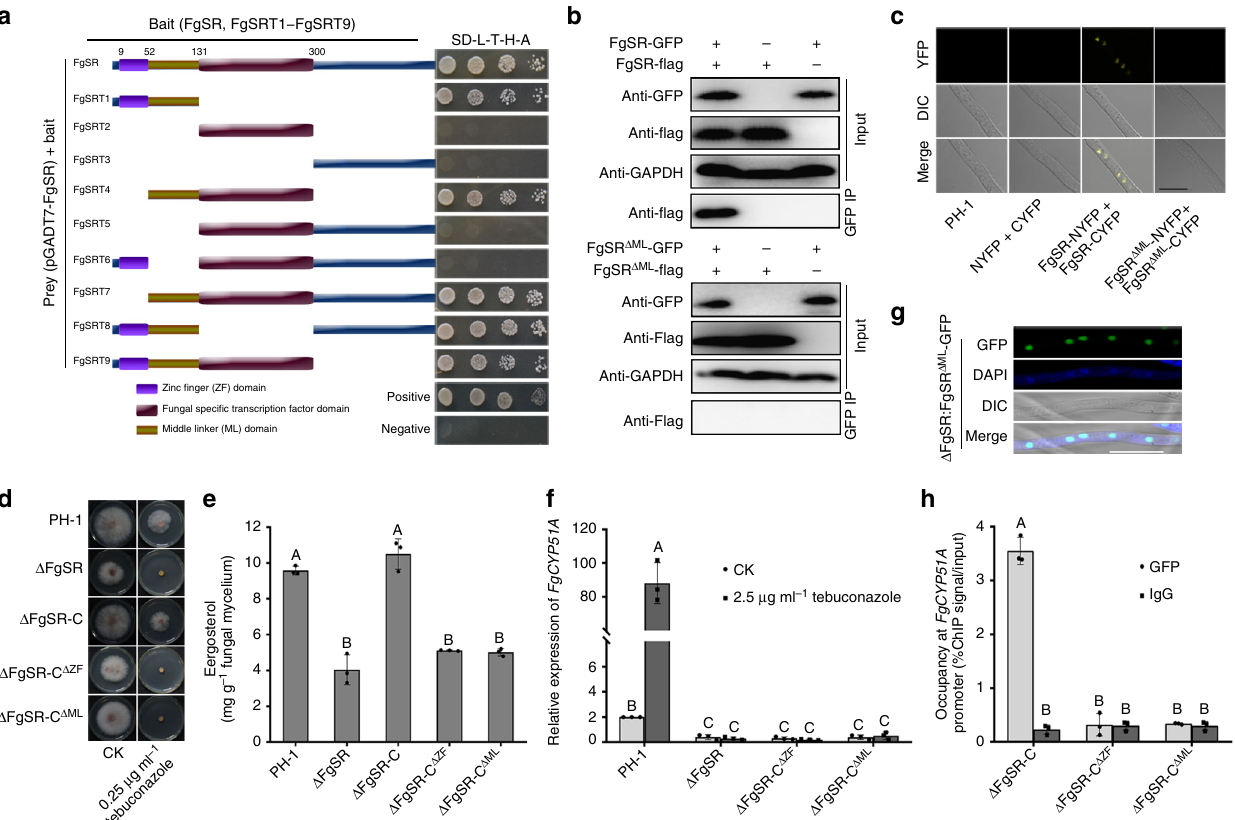
Fig. 5 The homodimerization of FgSR is required for its binding to the FgCYP51A promoter. a The yeast two-hybrid (Y2H) assay revealed that the middle linker (ML) domain of FgSR is required for its homodimerization. Serial dilutions of yeast cells (cells ml − 1 ) transferred with the prey (pGADT7-FgSR) and bait (a series of truncated FgSR (indicated in the left panel) constructs were assayed for growth on SD-Leu-Trp-His plates (right panel). b FgSR lacking of the ML domain did not interact with itself in the co-immunoprecipitation (Co-IP) assay. c FgSR lacking of the ML domain did not interact with itself in the bimolecular fl uorescence complementation (BiFC) assay. FgSR-NYFP/FgSR Δ ML -NYFP, and FgSR-CYFP/FgSR Δ ML -CYFP were co-transformed into the wild type. YFP signals were observed using confocal microscopy. Bar = 10 μ m. d The strain lacking the zinc fi nger (ZF) domain ( Δ FgSR-C Δ ZF ) and ML domain ( Δ FgSR-C Δ ML ) as well as the Δ FgSR mutant displayed greatly increased sensitivity to tebuconazole. e The strains Δ FgSR-C Δ ZF and Δ FgSR-C Δ ML exhibited reduced ergosterol content similar to Δ FgSR. f In Δ FgSR-C Δ ZF and Δ FgSR-C Δ ML , the expression of FgCYP51A was signi fi cantly decreased and could not be induced after the treatment with 2.5 μ g ml – 1 tebuconazole for 6 h. g FgSR Δ ML -GFP is still localized in the nucleus. Bar = 10 μ m. h Δ FgSR-C Δ ZF and FgSR Δ ML -GFP did not enrich at the FgCYP51A promoter. ChIP- and input-DNA samples were quanti fi ed by quantitative PCR assays with the primer pair A2 indicated in Fig. 2b, and rabbit IgG was used as a control. Data presented are the mean ± s.d. ( n = 3). Bars followed by the same letter are not signi fi cantly different according to a LSD test at P =